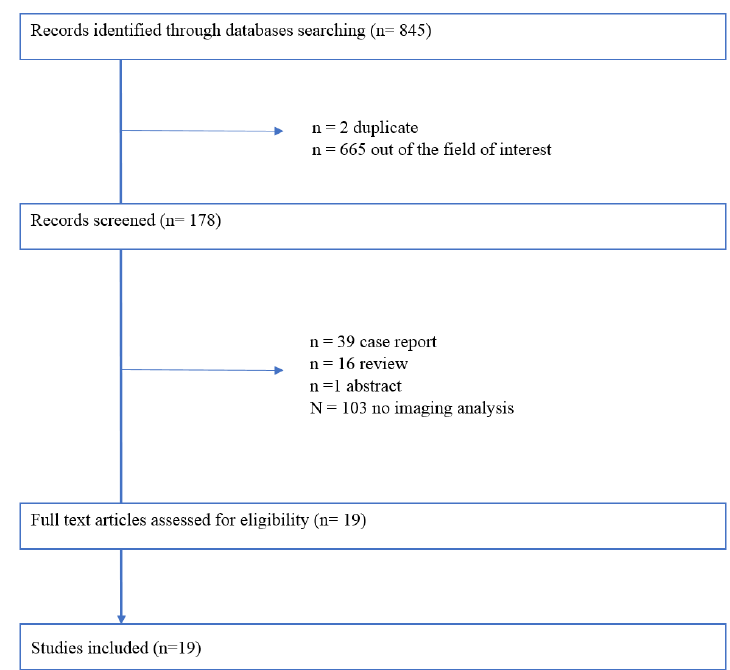
Figure 1. Outline of the search strategy.